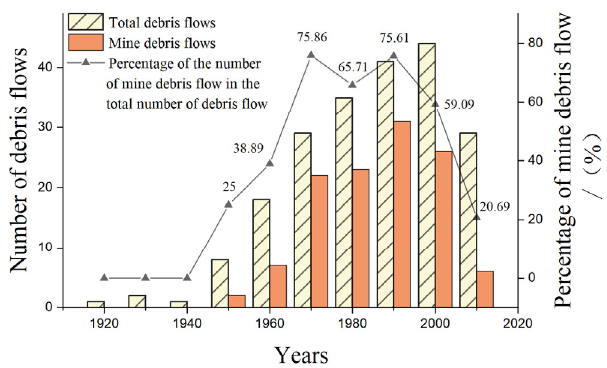
Figure 2. Trends in the number of major debris fl ow/mine debris fl ow disasters over a wide span of time.